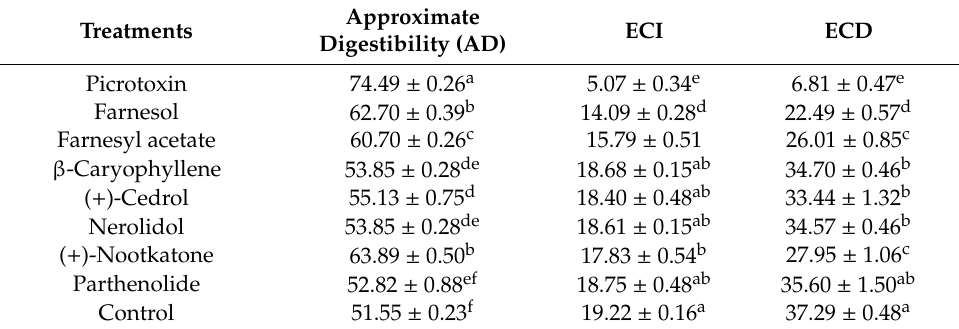
Table 2. Impact of di ff erent sesquiterpenes on the growth indices of red palm weevil larvae.